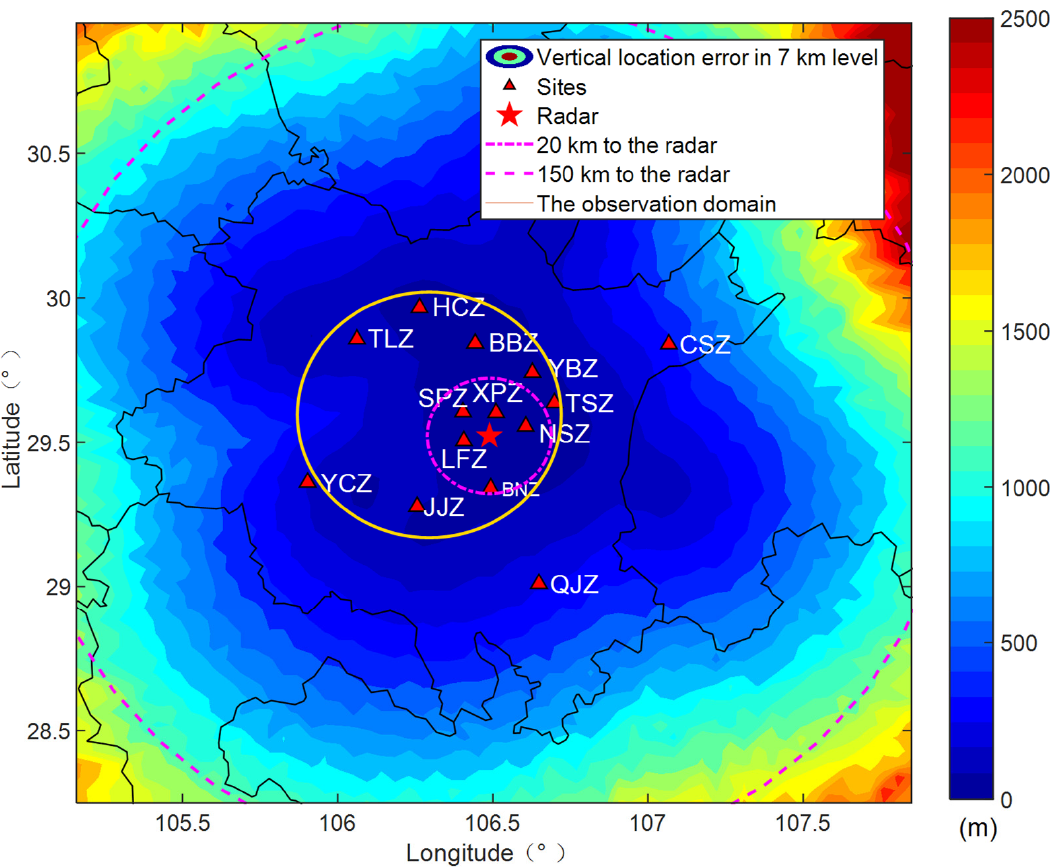
Figure 1. The Chongqing sensor network. The colored contours indicate the vertical location errors in the 7-km range estimated by Monte Carlo simulation. The magenta dashed-dot and dashed circles show the ranges of 20 km and 150 km from the radar, respectively. The yellow circle shows the coverage of the observation domain.